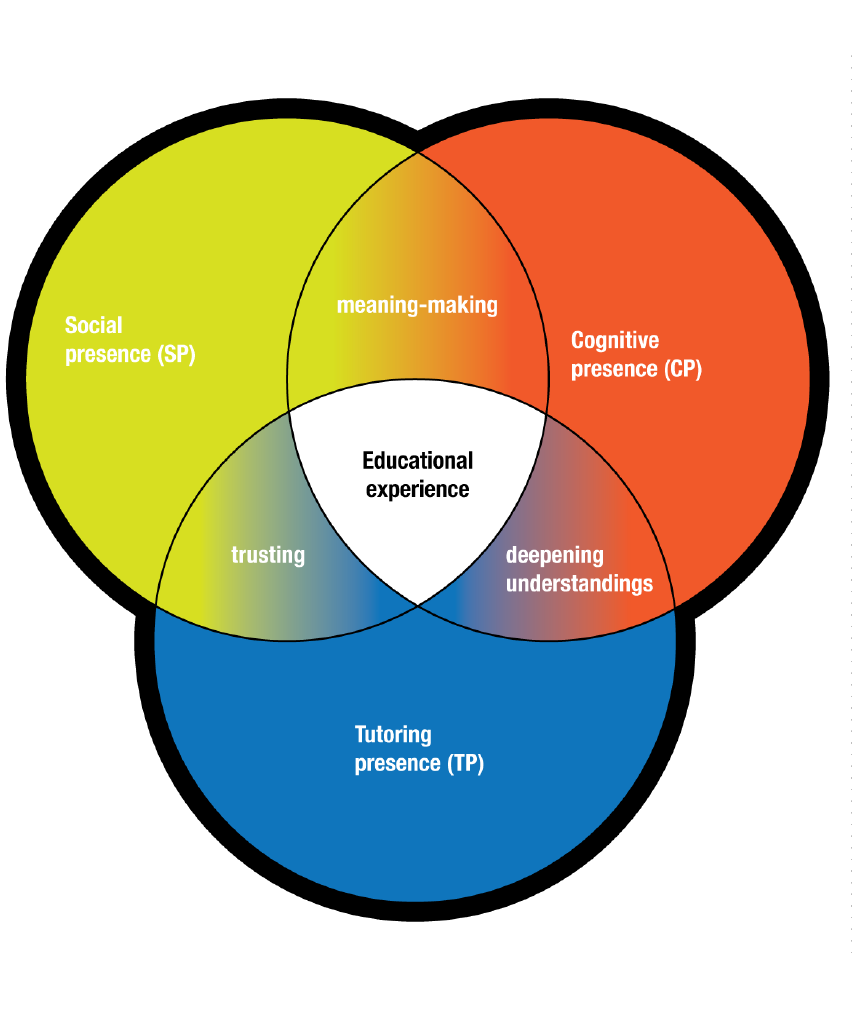
Figure 2. Community of Inquiry model indicating presences and